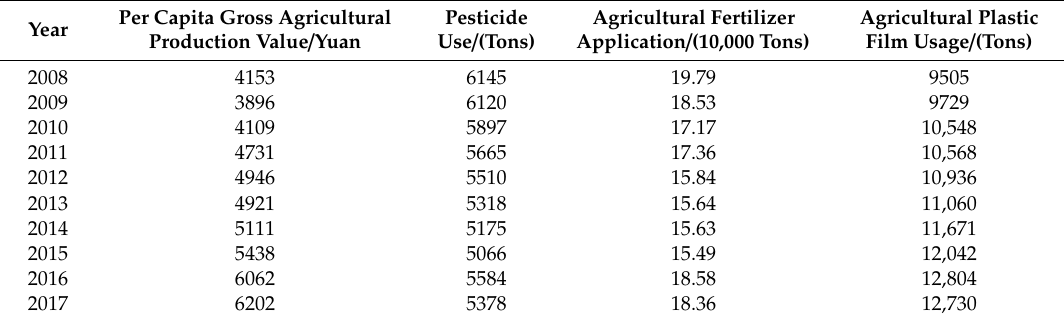
Table 1. Raw data for the selected indicators.